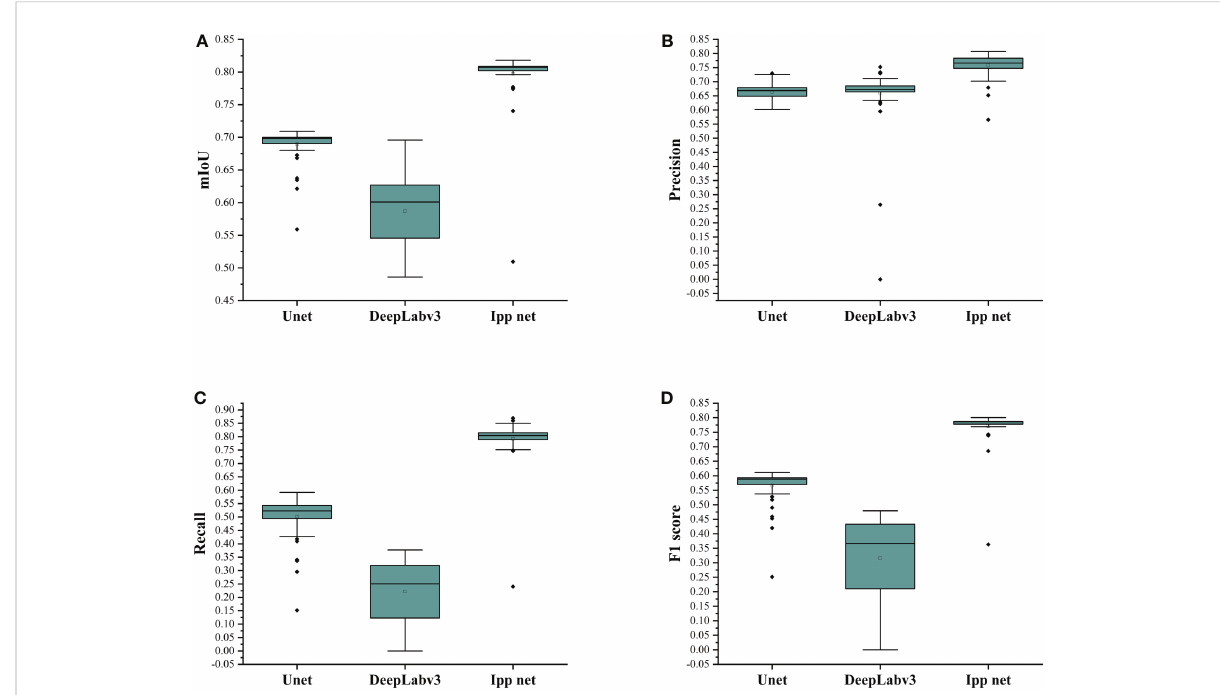
FIGURE 9 Evaluation indicators of U-Net, DeepLabv3+ and Ipp Net models of different epochs. (A) mIoU; (B) Precision; (C) Recall; (D)